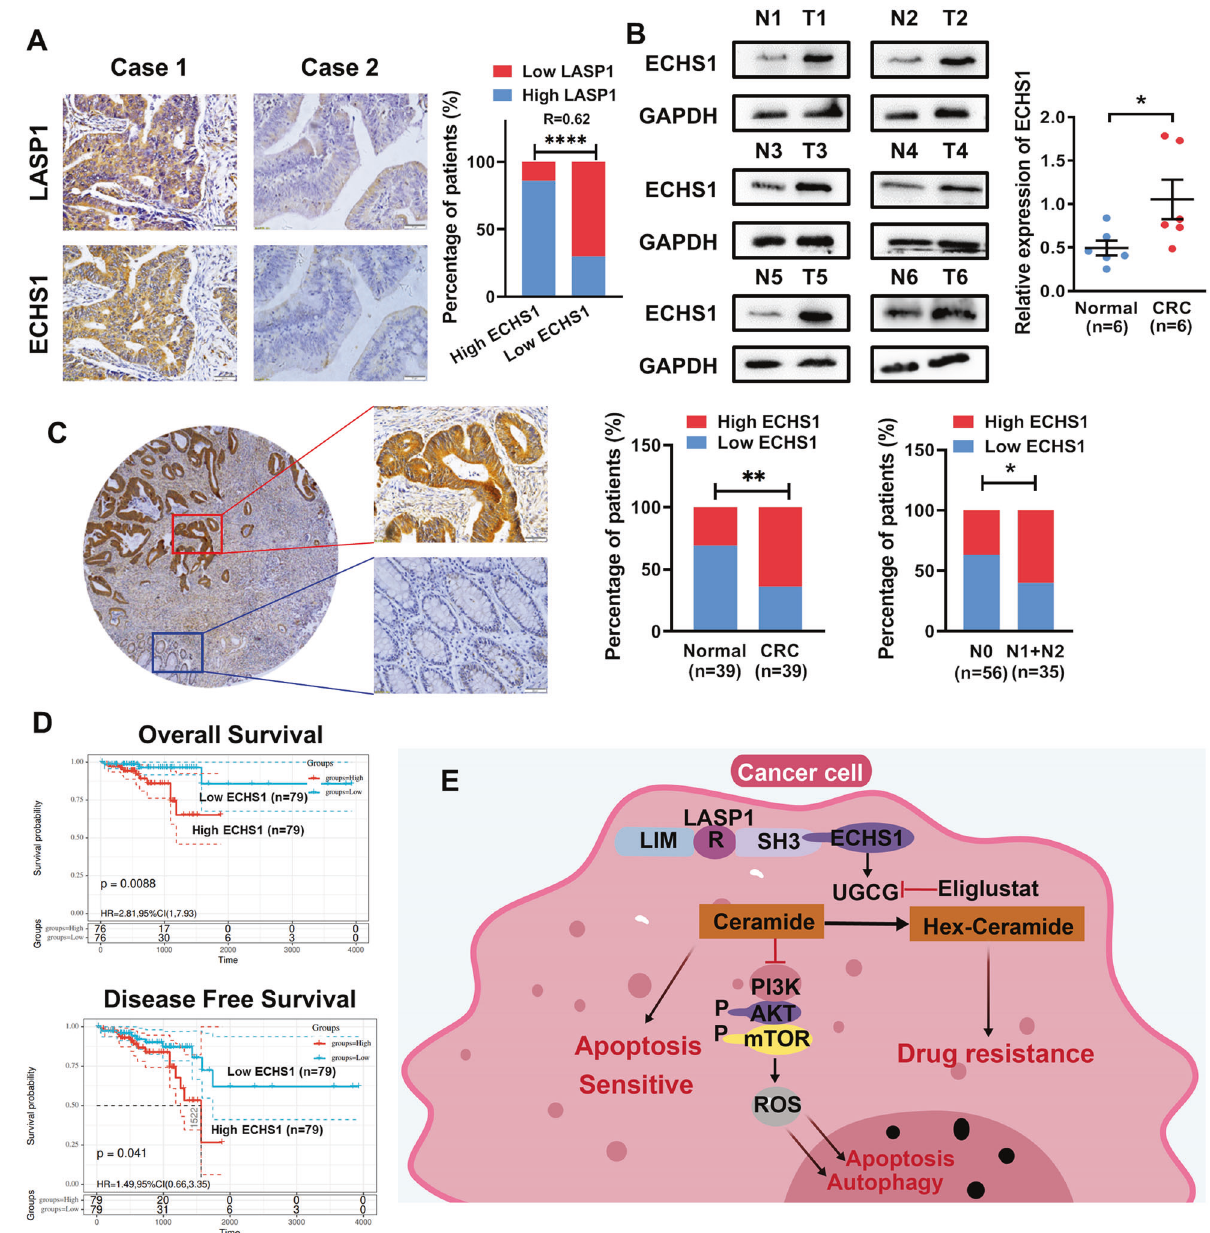
Fig. 6 Overexpression of ECHS1 is associated with tumor progression and poor prognosis of CRC. A Representative images of IHC staining analyses of LASP1 and ECHS1 in CRC tissues. B Western blot analysis of ECHS1 in CRC tissues (T) and adjacent nontumor tissues (N). The scatterplot on the right shows the relative expression of ECHS1 in normal and CRC tissues (normalized to GAPDH, P < 0.05). C Left panel: immunohistochemistry (IHC) analysis of ECHS1 in CRC tissues and adjacent nontumor tissues. Right panel: histogram representing IHC results in CRC tissues (T) and adjacent nontumor tissues (N) and with or without lymph-node metastasis. D Kaplan – Meier survival curves and univariate analyses (log rank) for CRC patients with distinct expression levels of ECHS1. E Sketch map of the mechanism of ECHS1-mediated CRC proliferation and drug